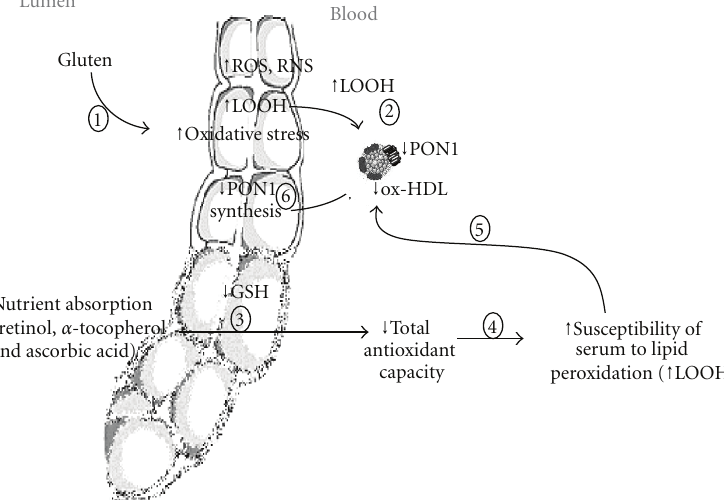
Figure 3: Possible molecular mechanisms involved in increased lipid peroxidation and decreased PON1 activity in celiac disease. Gluten ingestion induces an increased oxidative stress, due to overproduction of free radicals (ROS and RNS) (1). The higher levels of ROS can trigger lipid peroxidation (LOOH) in intestinal mucosa and blood (2). Oxidative stress could be favored by lower serum antioxidant capacity resulting from lower absorption of dietary antioxidants due to mucosal damage (3). All the aforementioned changes could explain the higher susceptibility of serum to lipid peroxidation (4) and the compositional alterations of HDL with consequent decrease of PON1 activities (5). In addition to the inhibition exerted by lipid peroxidation products, the lower PON1 activity could be mediated by inhibition of PON1 synthesis from gastrointestinal cells